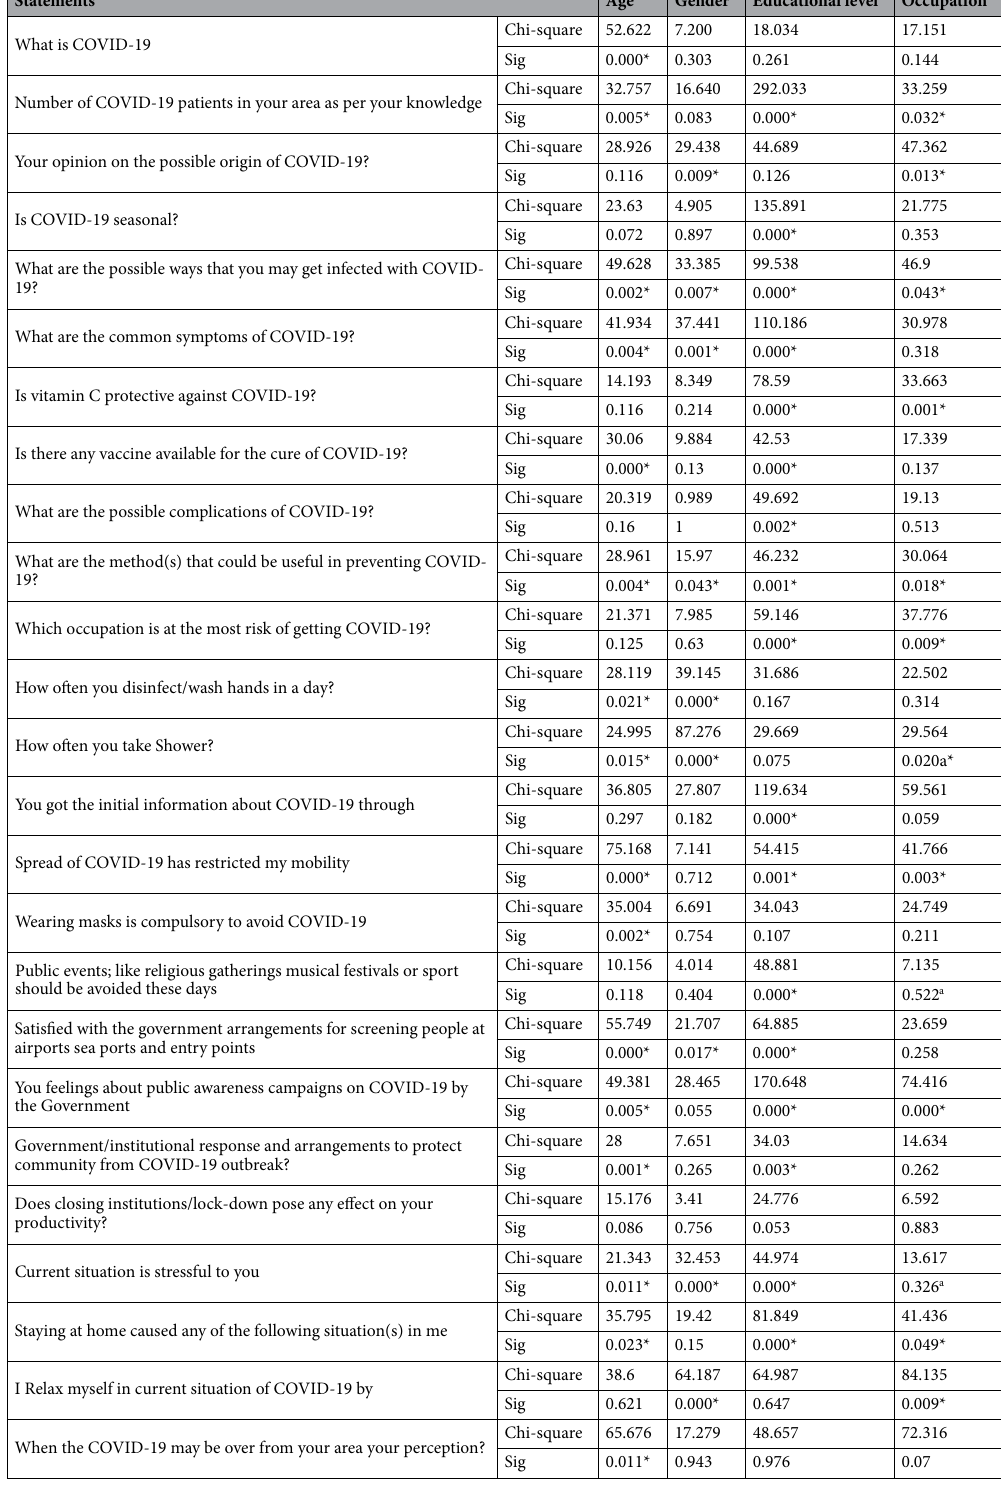
Table 2. Pearson Chi-square tests. *The Chi-square is significant (two variables are not independent) at the 0.05